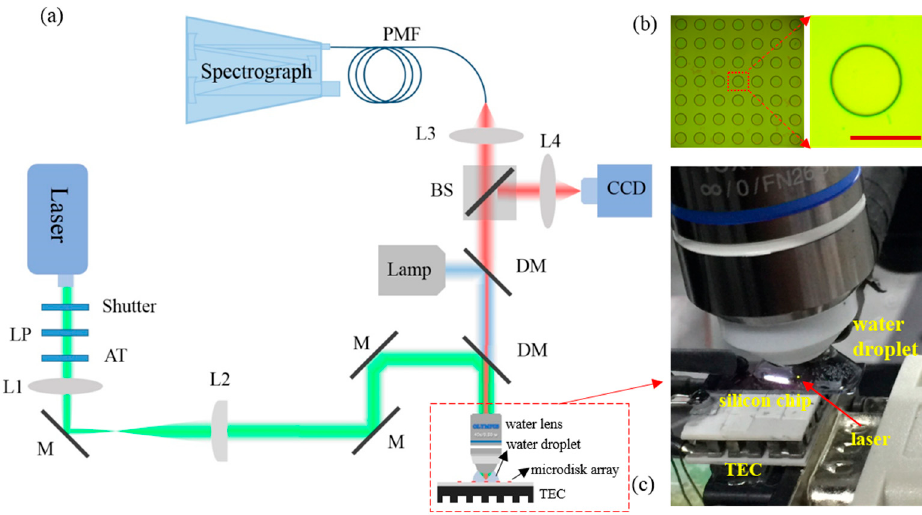
Figure 1. Optical system setup. ( a ) Schematic of lasing chemical sensor pumped by water-immersion-objective (WIO). LP: linear polarizer; AT: attenuator; L: lens; M: mirror; DM: dichroic mirror; BS: beam splitter; PMF: polarization-maintaining fiber. ( b ) Optical images of microdisk array and single microdisk, the scale bar is 40 µ m. ( c ) Close-up image of the microdisk laser-based chemical sensor under WIO. The silicon chip is mounted on a home-made TEC which is connected to a temperature controller (Thorlabs, TED4015).